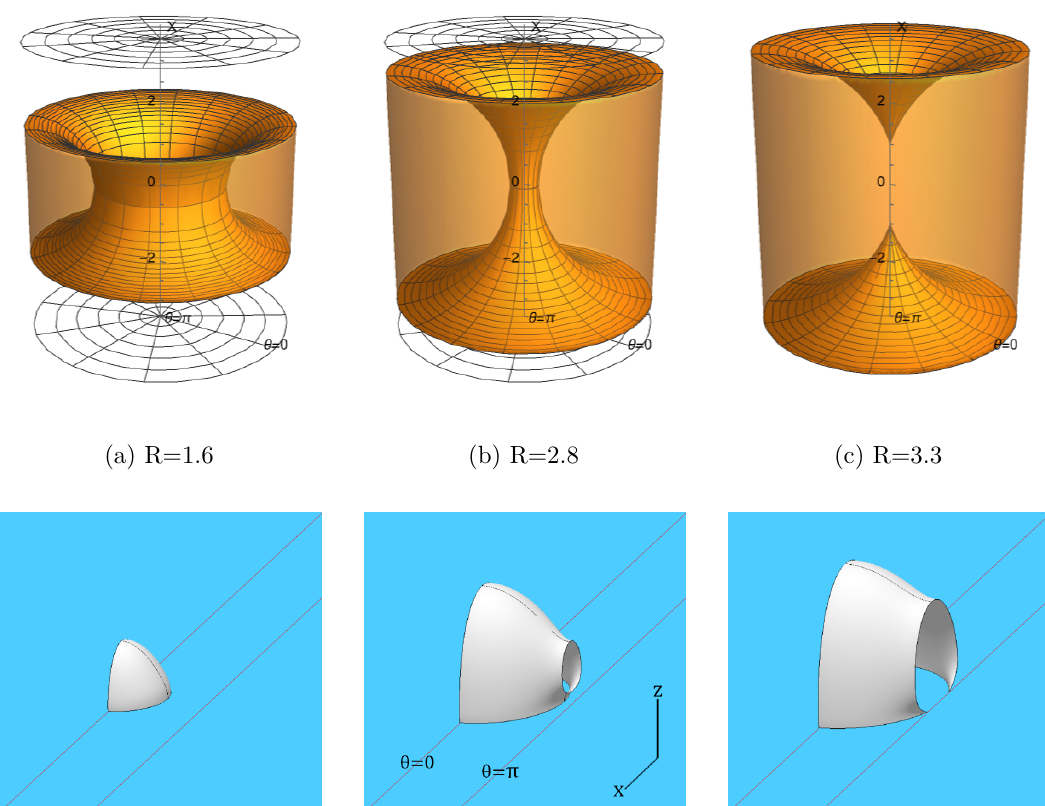
Figure 10. Top: Entangling regions in N = 4 SYM on S 2 for increasing values of R . This is the sphere analog of the process in figure 3. Bottom: Minimal surfaces of the functional (B.15). The direction φ is omitted, since the surface possesses axial